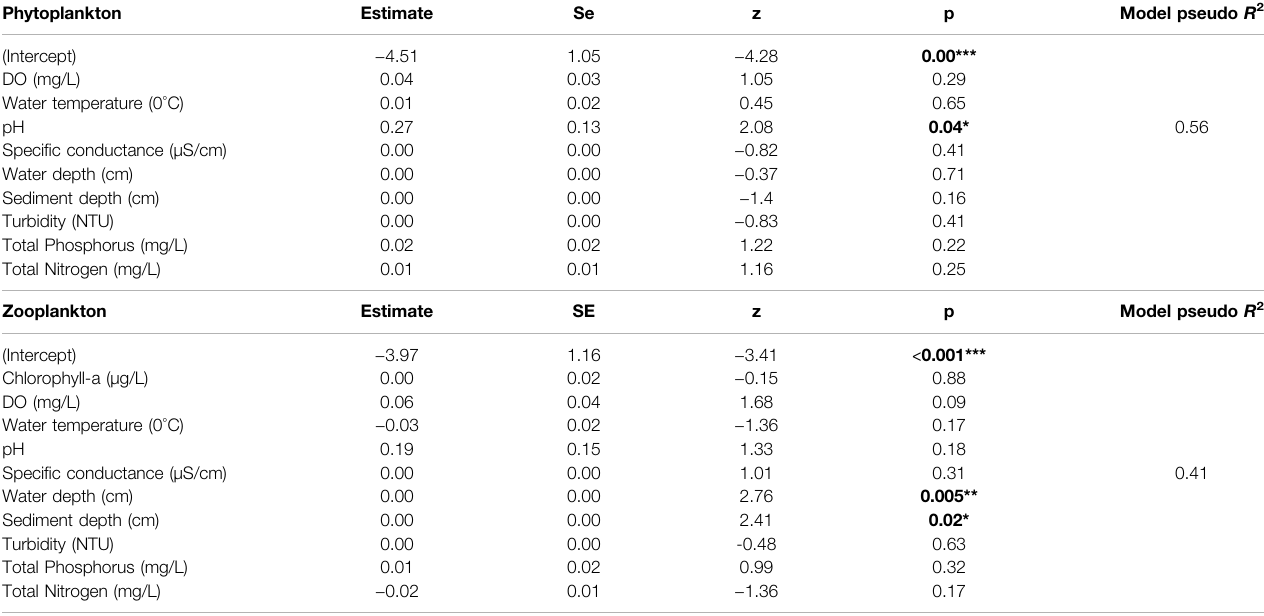
TABLE 3 | Results of beta regression analyses when the response variable, local contributions to beta diversity (LCBD), was explained by local environmental variables. Phytoplankton